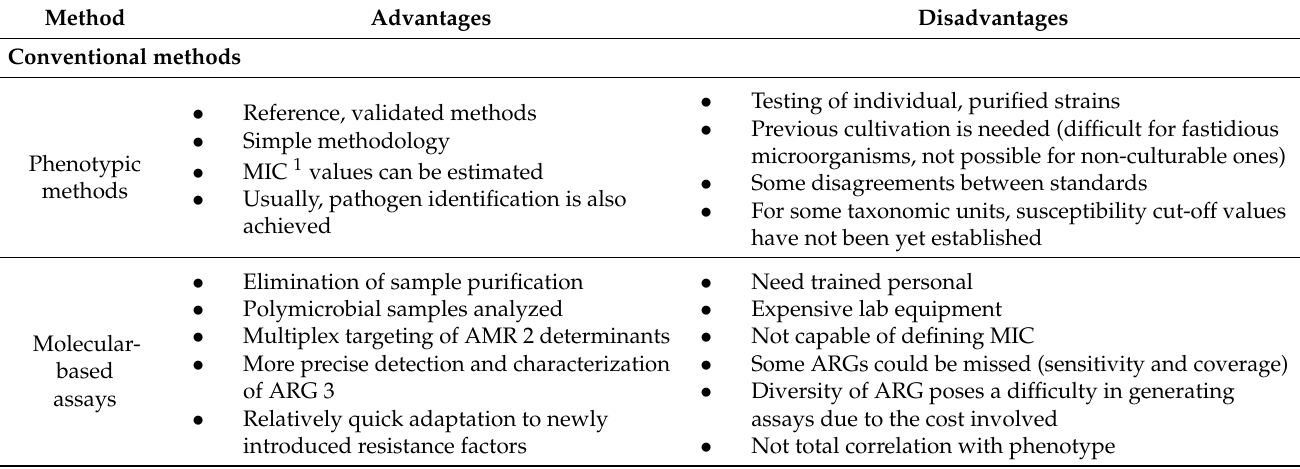
Table 5. Advantages and disadvantages of AMR diagnostic methods and technologies. Method